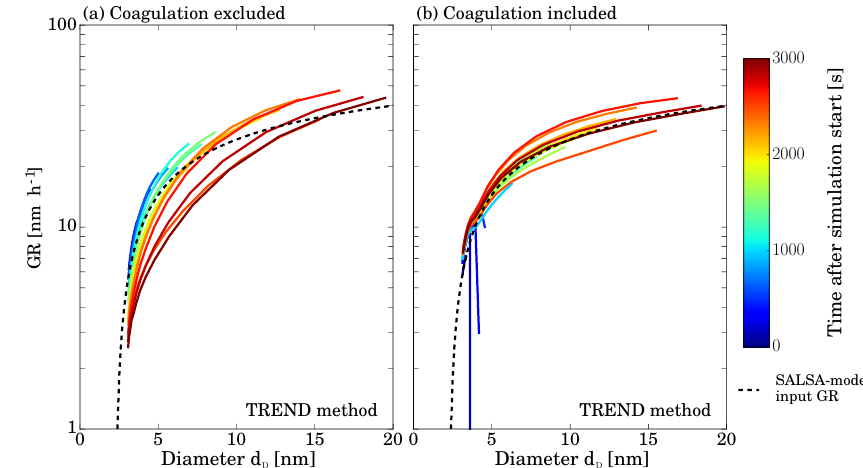
Figure C1. Analyzed (straight lines) and set growth rate (dashed lines) as a function of particle diameter. Panel (b) shows results obtained by considering the effect of coagulation while results depicted by panel (a) were determined neglecting coagulation.